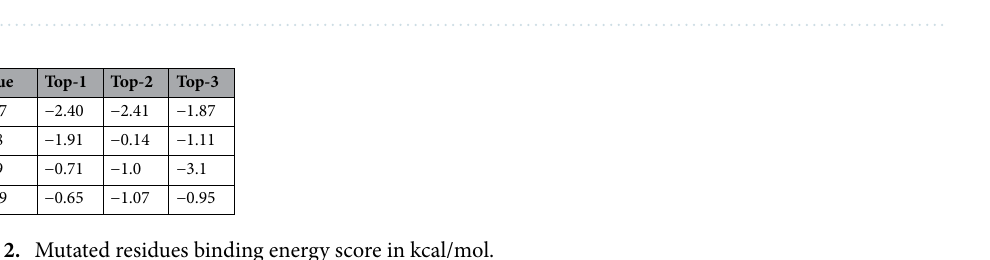
Figure 9. WaterSwap based absolute binding free energy of each compound estimated by TI, FEP, and BENNETTS methods.